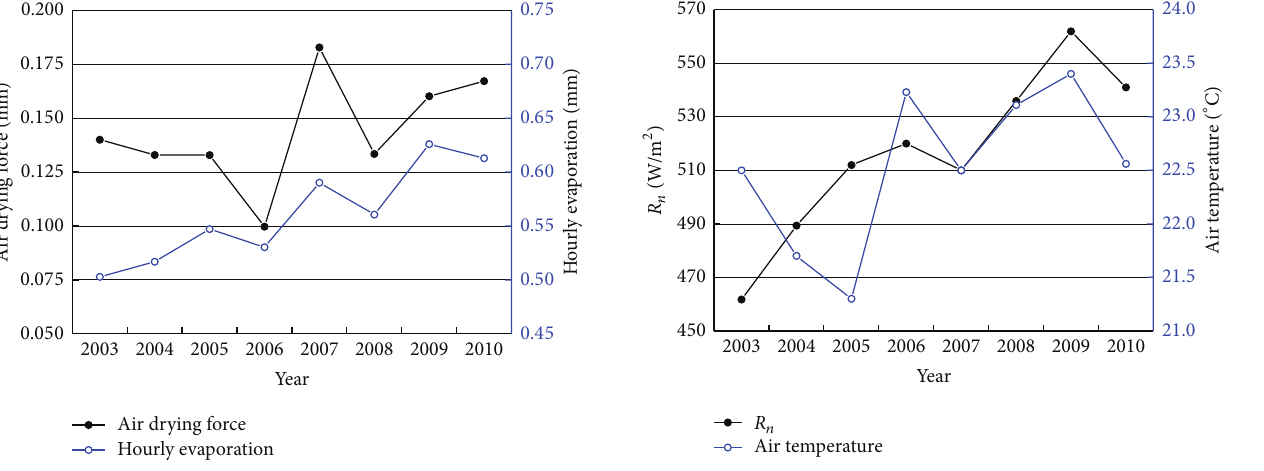
Figure 8: The variation trends in annual mean of 1-hour (13:10– 14:10) air temperature and net radiation in Dongping Lake during 2003–2010 (open circle means air temperature, dot means net